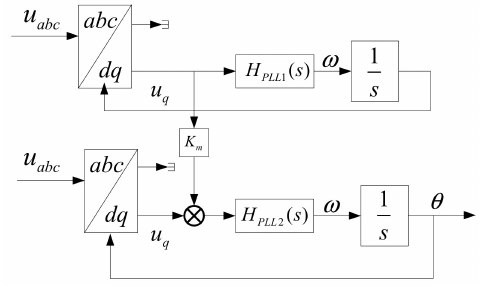
Figure 7. Control block diagram of the